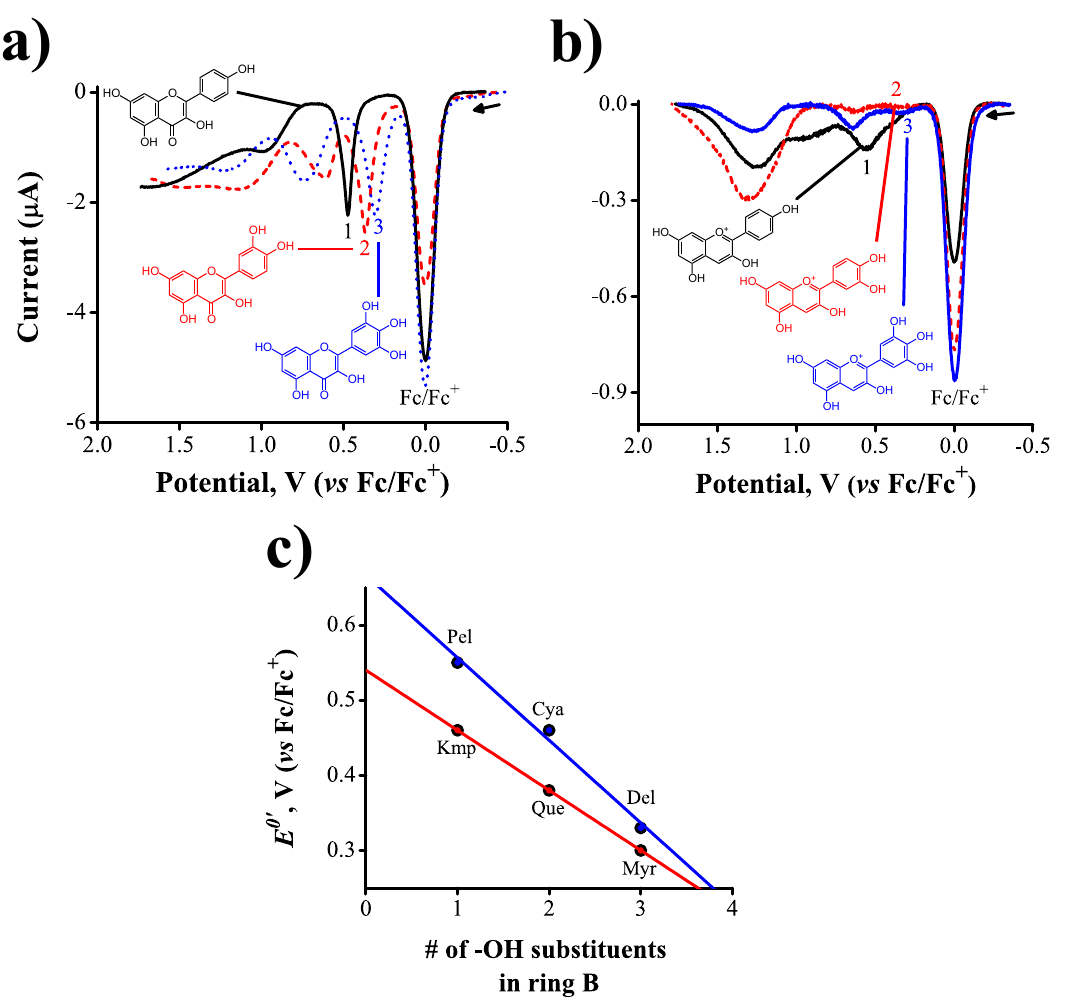
Figure 3. ( a ) square wave voltammograms ( Ψ vs. E ) of 0.05mM kaempferol (1), quercetin (2), and myricetin (3) in 0.5mM ferrocene + 0.1M TEATFB; ( b ) square wave voltammograms of 0.01mM pelargonidin (1) in 0.25mM ferrocene + 0.1M TEATFB, cyanidin (2) in 0.4mM ferrocene + 0.1M TEATFB, and delphinidin (3) in 0.5mM ferrocene + 0.1 M TEATFB, ∆ E = 50mV, f = 1Hz. The numbers indicate how many substituents are present in ring B of the corresponding flavonoid; and ( c ) linear correlations between formal oxidation potential and number of OH substituents in the ring B of